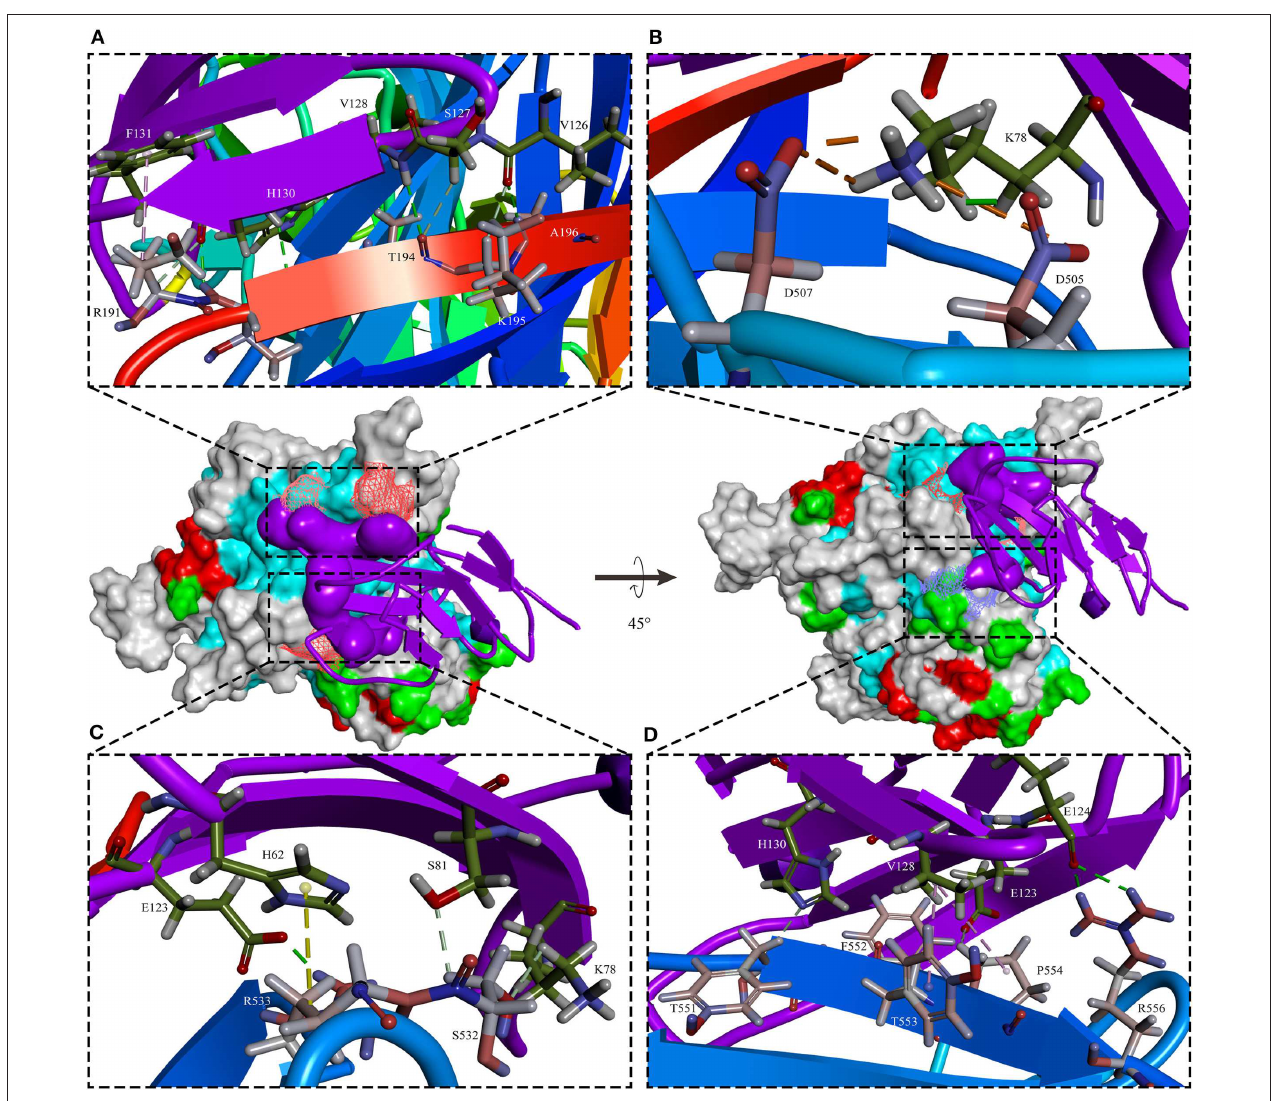
FIGURE 3 | The sSLAM receptor-binding sites with PPRV HNw. The typical β -sandwich structure with BED and AGFCC ′ β -sheets of the sheep SLAM (purple) bound to the β 4– β 6 hydrophobic groove governs in PPRV HNw head domain six-bladed β -propeller head (rainbow colors). In addition to the presence of a large number of hydrogen bonding interactions, D507 on PPRV HNw made an intermolecular salt bridge with K78 on sSLAM-V and also had Pi interactions with PPRV HN residues R191, R533, Y553, and SLAM residues F132, H63, K129. (A–D) showed four small segments of the binding interface in PPRV HNw-shSLAM